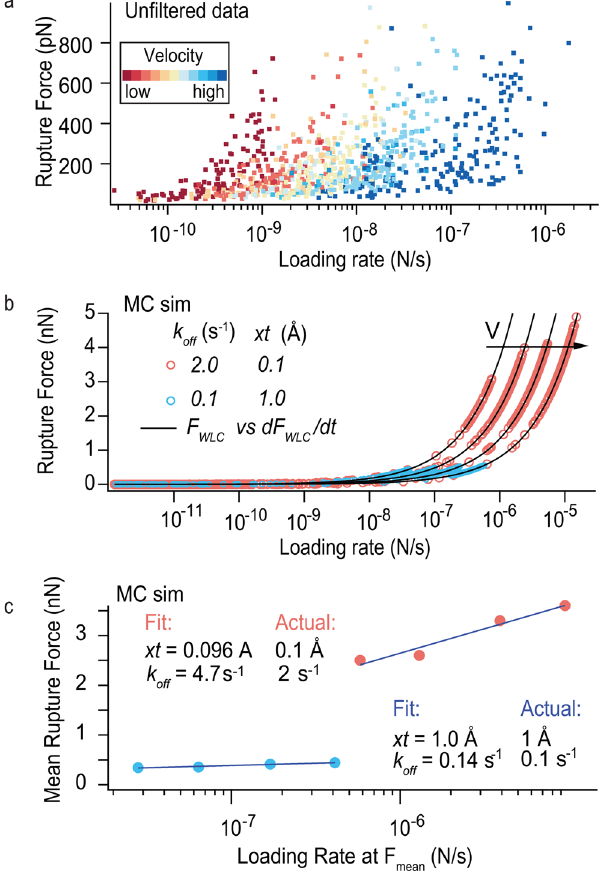
Figure 1. Examples of analyzing polymer-based DFS data. ( a ) All rupture-forces vs loading-rate at rupture pairs for the retraction velocities. ( b ) Monte Carlo simulation of rupturing two different bonds (blue dots and red circles) using the same polymer linker (i.e. same WLC parameters). The arrow indicates data sets of increasing retraction velocity. ( c ) Data from ( b ) plotted as mean rupture force vs mean loading rate, with fits of the linear DFS model. Fit parameters and a discussion of errors are given in Supplementary Table